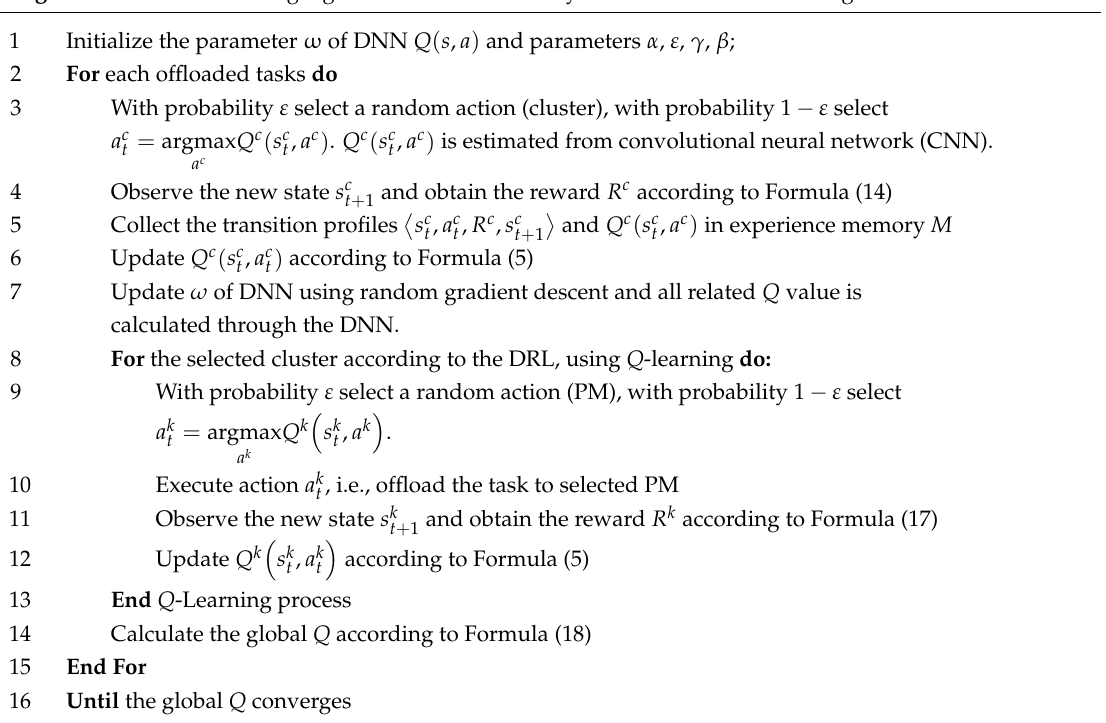
Algorithm 2. Task offloading algorithm based on two-layered reinforcement